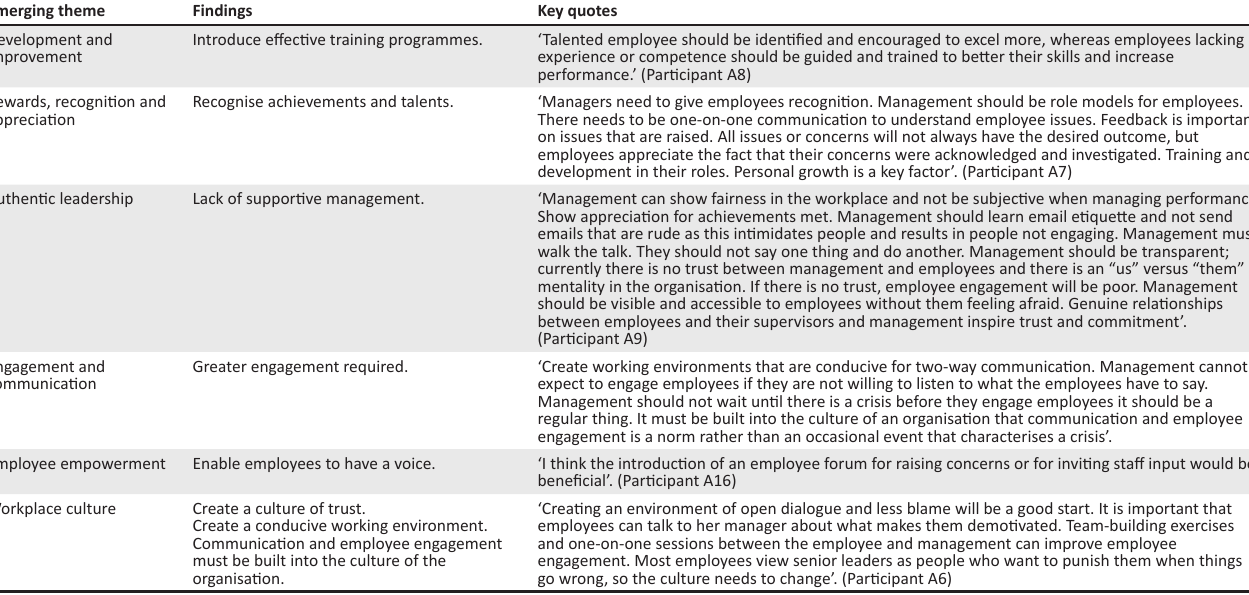
TABLE 6: Summary of findings for question 2 – Employee engagement. What can management do to increase and improve employee engagement? Emerging theme